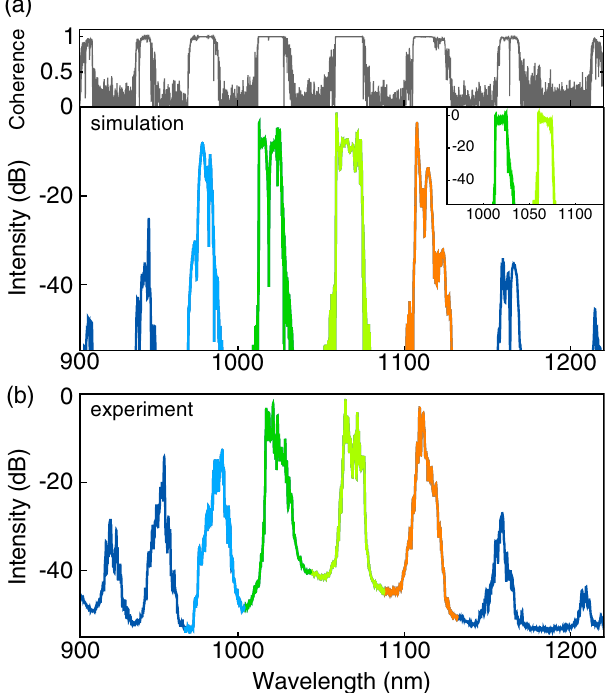
Figure 3. Output spectra in simuation ( a ) and experiment ( b ). Inset: spectral shape of the DS and RDS at the input of the nonlinear fiber. Upper panel: coherence degree for corresponding spectral components calculated by the method described in 24 .